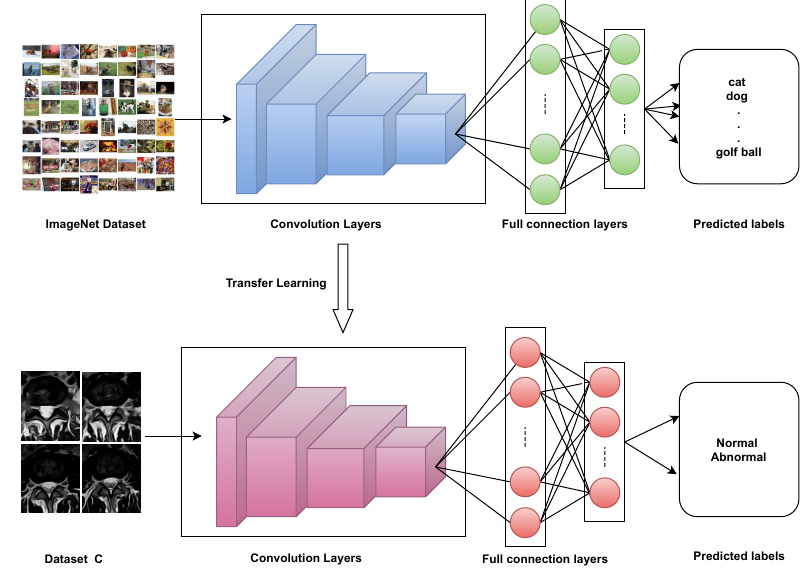
Figure 11. Transfer learning from ImageNet.